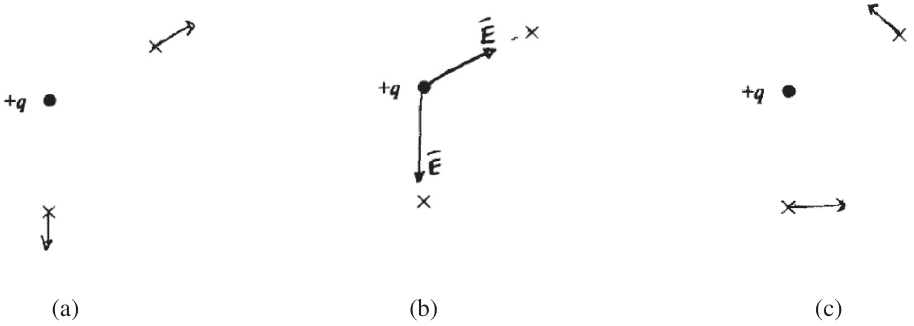
FIG. 3. We present examples of the drawings that students made in the first question of the electricity version. (a) An example of the drawing category vector diagram. (b) An example of the drawing category, hybrid vectors, and field lines. (c) An example of the drawing category, confusion between electric and magnetic fields.